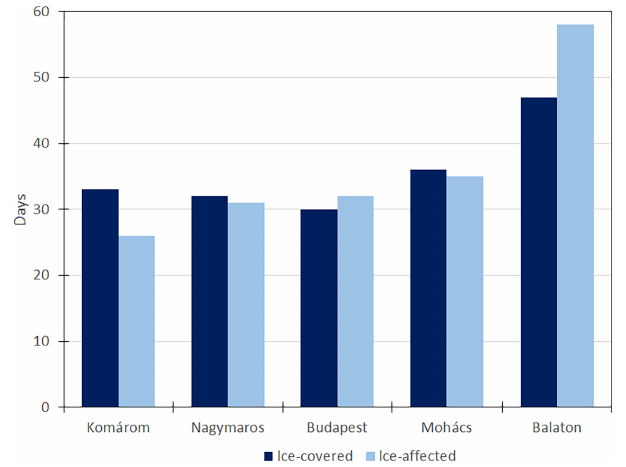
Figure 3. The average length of the ice-covered and ice-affected seasons of the Danube and Lake Balaton: